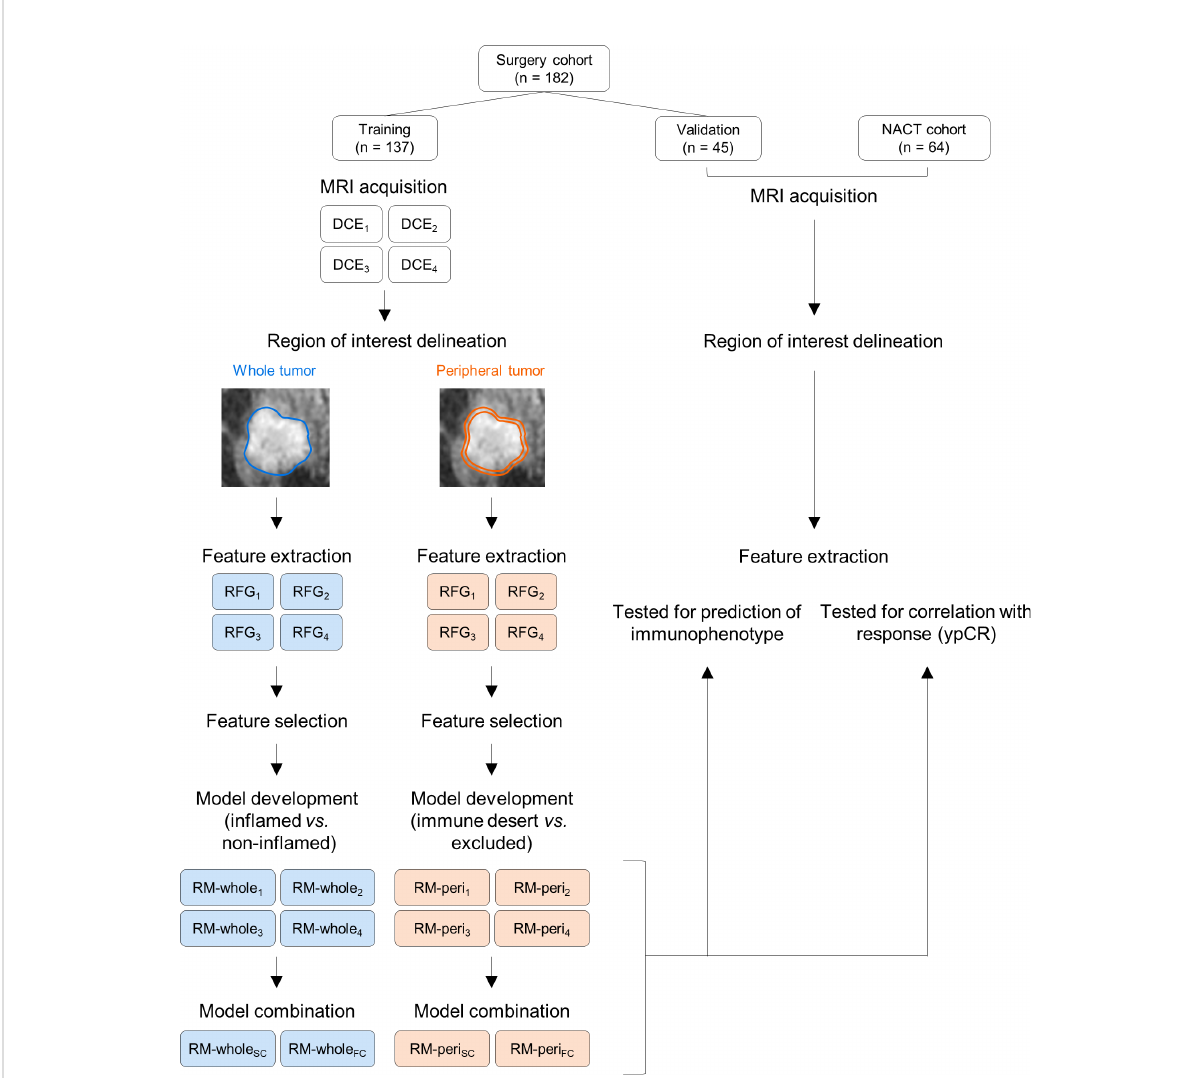
FIGURE 2 The study work fl ow for developing radiomic models and their validation. NACT, neoadjuvant chemotherapy; MRI, magnetic resonance imaging; DCE, dynamic contrast enhanced; RFG, radiomic feature group; RM, radiomic